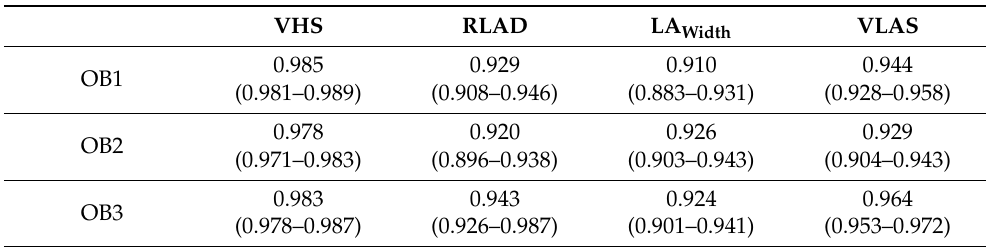
Table 7. Intraobserver agreement of each observer obtaining the radiographic measurements in conventional and inverted